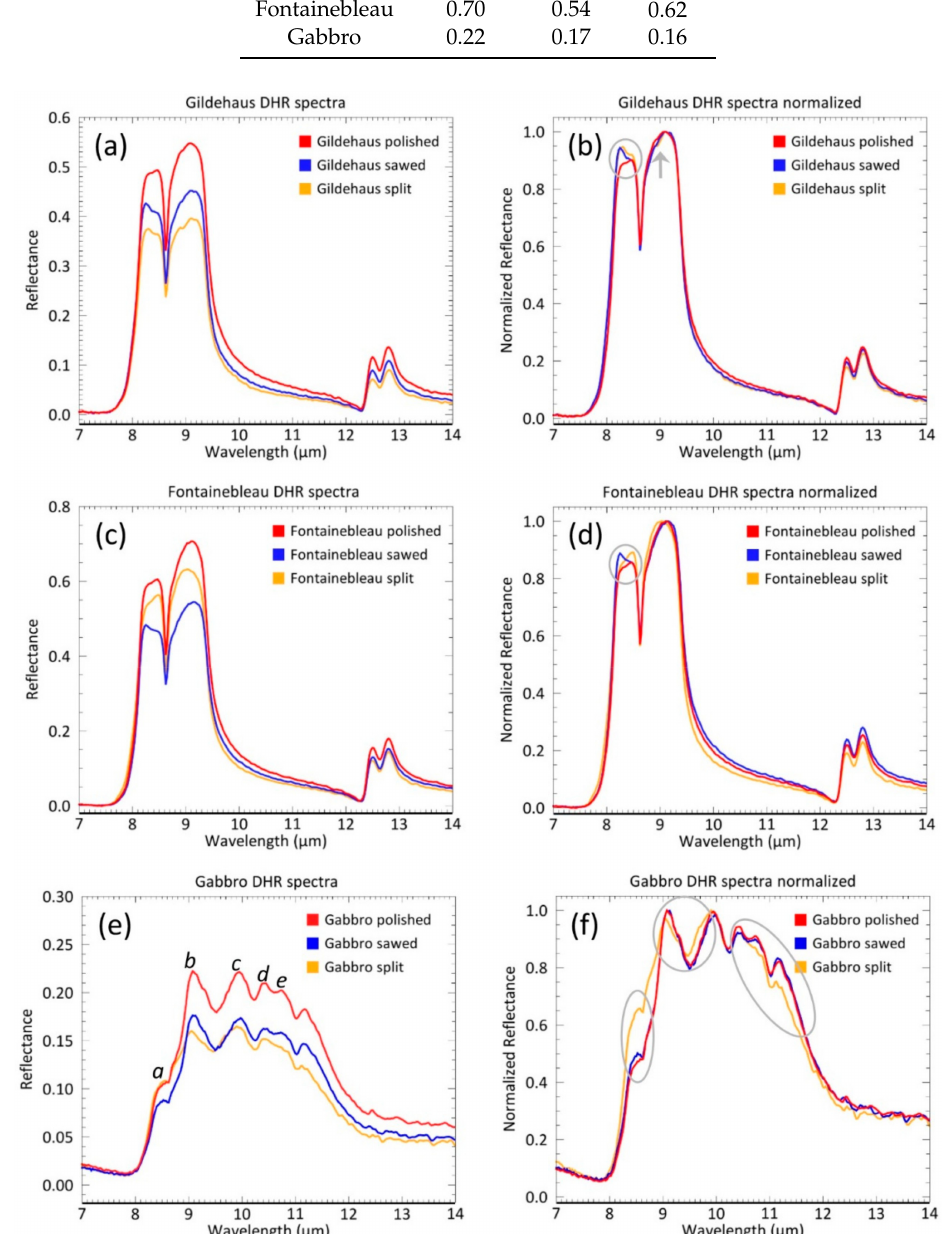
Figure 4. Mean reflectance spectra and normalized mean reflectance spectra of the Gildehaus ( a , b ), Fontainebleau ( c , d ) and Gabbro ( e , f ) DHR measurements. Circles and arrow indicate spectral shape